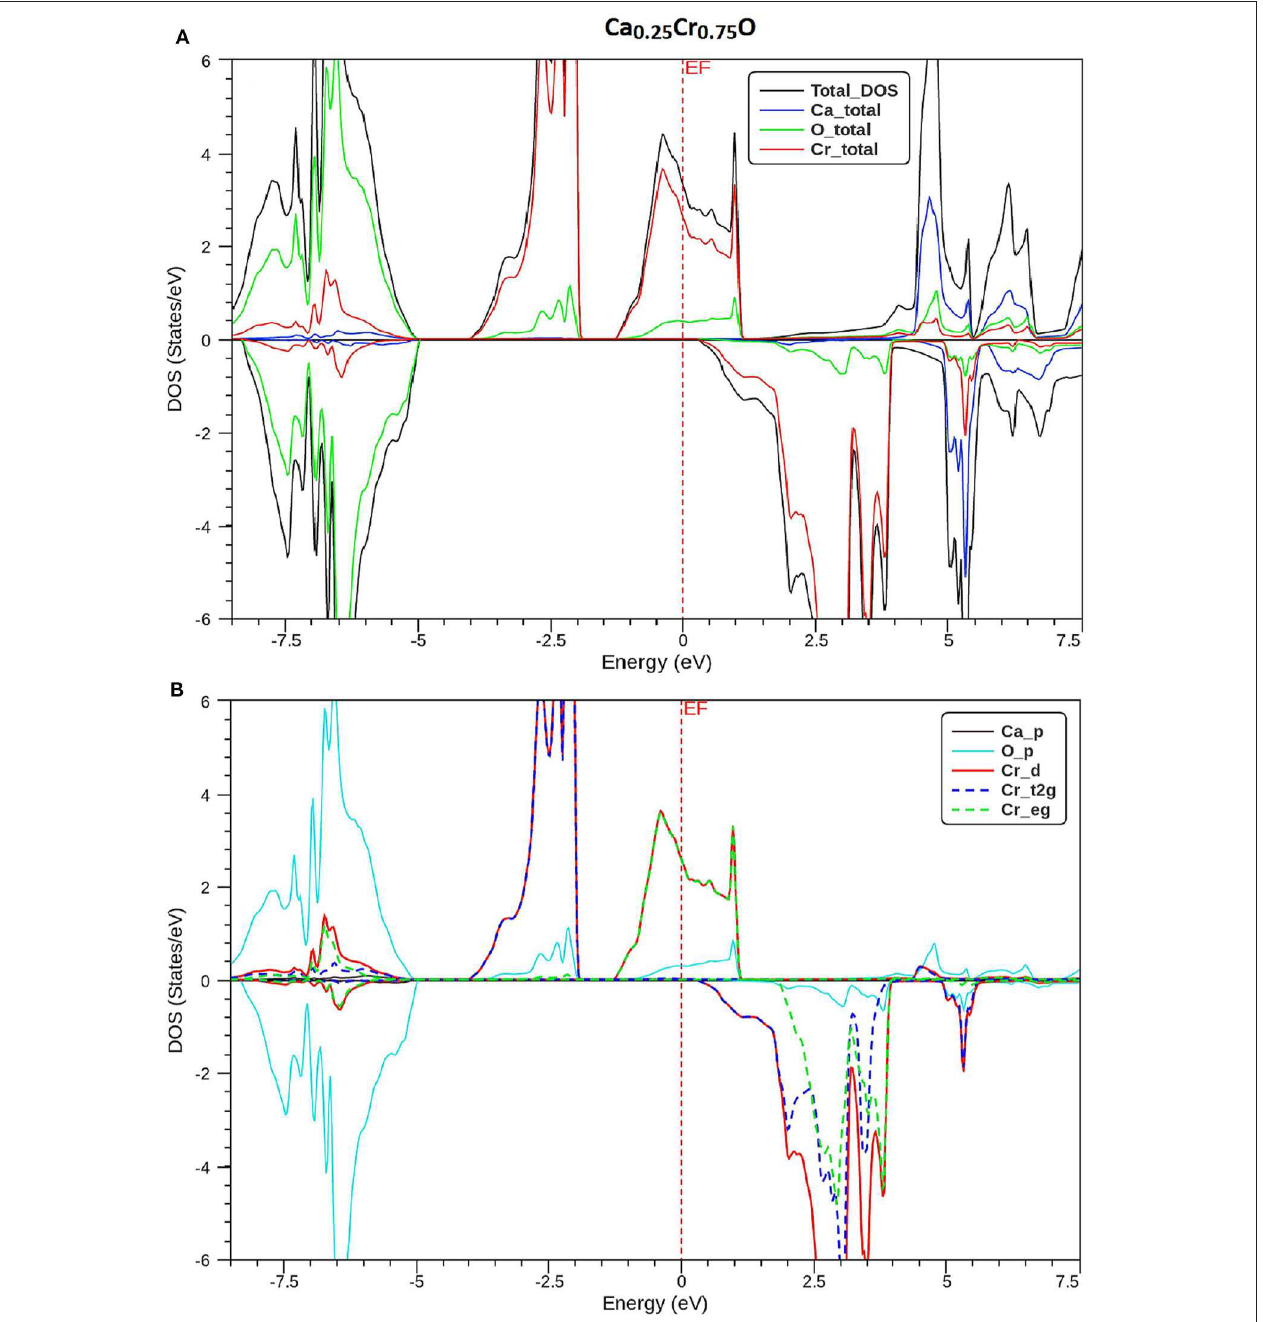
FIGURE 10 | Spin-polarized total and partial densities of states (DOS) of Ca 0.25 Cr 0.75 O. The Fermi level is set to zero ( vertical dotted line ). (A) Total DOS of Ca, Cr, and O and (B) Partial DOS of p-Ca, p-O, d-Cr, t2g_d-Cr, and eg_d-Cr.